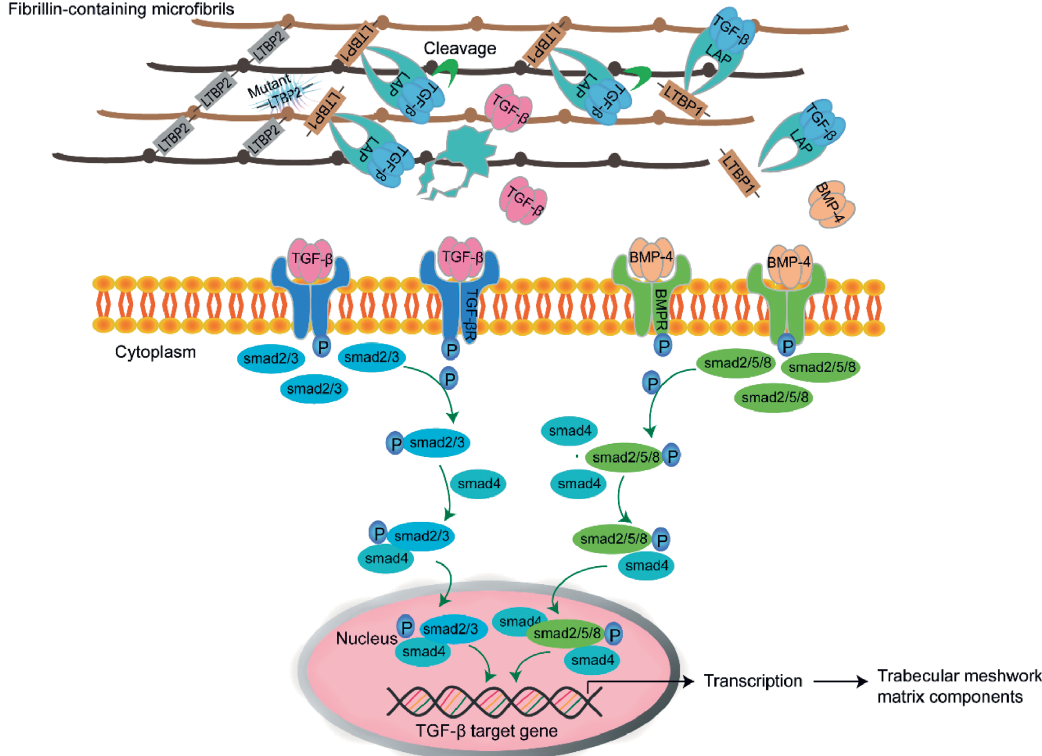
Figure 2: LTBP2 indirectly mediates the TGF-β/BMP signal pathway to regulate elastogenesis or anchors to components of the matrix of the trabecular meshwork. Mutant LTBP2 loses competition with LTBP1 for fibrillin-containing microfibrils, which increases the concentration of activated TGF-β and upregulates TGF-β signal to activate target gene. BMP signal negatively regulates the TGF-β signal to downregulate TGF-β gene expression. LTBP2: latent transforming growth factor-beta binding protein 2; TGF- β : transforming growth factor-beta; BMP: bone morphogenetic protein; LAP: latency-related protein; TGF- β R: transforming growth factor-beta receptor; BMPR: bone morpho- genetic protein